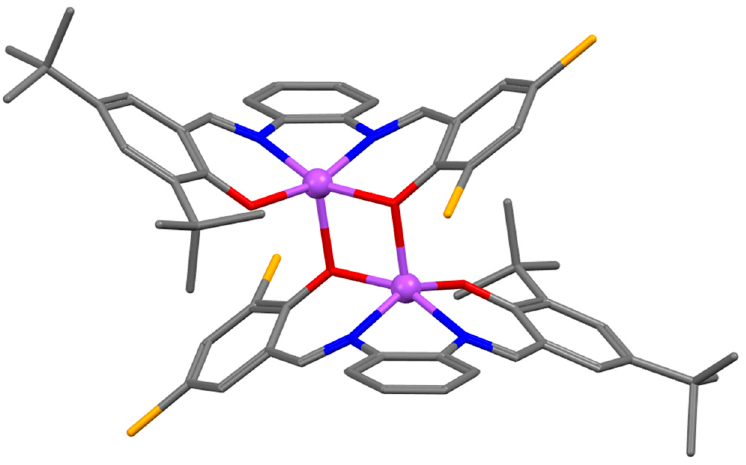
Figure 5. Crystal structure of the (6) 2 dimer. Adapted from Ref. [27].